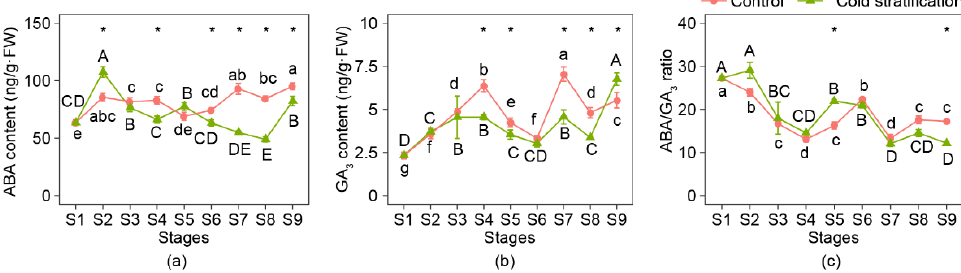
Figure 4. Content and ratio of ABA and GA 3 of P. emodi seeds at nine stages during stratification. ( a ) ABA; ( b ) GA 3 ; ( c ) ABA/GA 3 ratio. Note: Lowercase letters represent the significance of differences between stages of control ( p < 0.05); capital letters represent the significance of differences between stages of cold stratification ( p < 0.05); * represents the significant difference between treatments at the same stage ( p < 0.05).